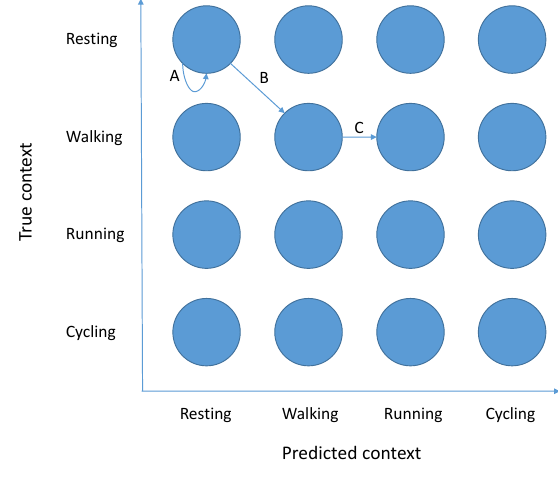
Figure 1. Markov chain, where each state represents a (true, predicted) context of the user. The states are fully connected, including connections to themselves, although most transitions were omitted for clarity. Transition A, for example, models the situation where the user is continually resting, and his/her context is recognized as such. For Transition B, the user started walking, which was correctly recognized. Finally, Transition C implies an incorrect classification of walking as